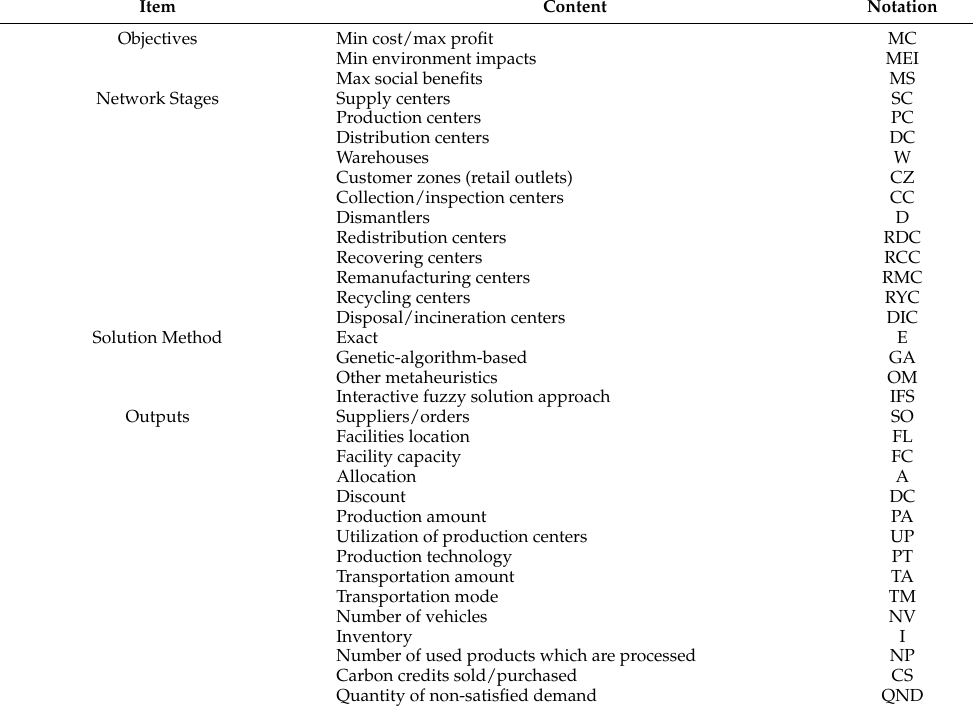
Table 4. Abbreviations comparison